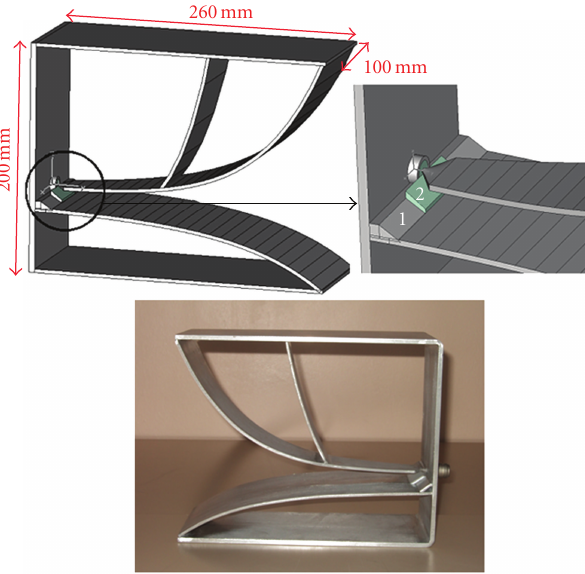
Figure 1: The elementary antenna (CAD model and realized geometry).